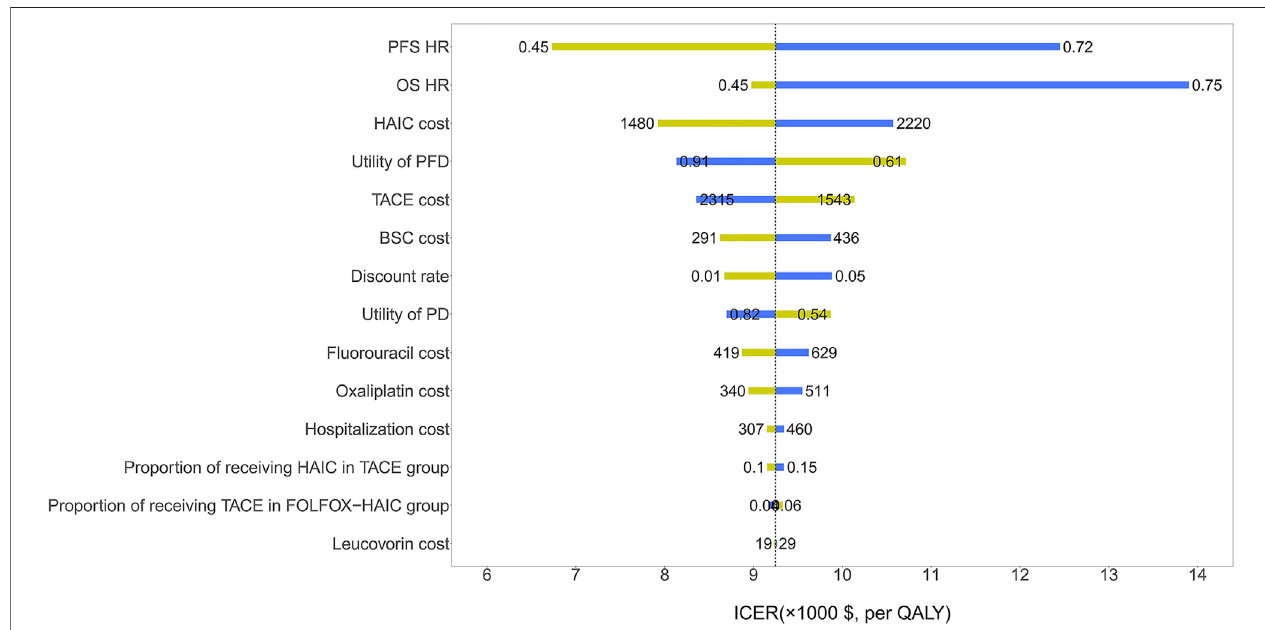
FIGURE 2 | | One-way sensitivity analysis results of the FOLFOX-HAIC strategy versus TACE strategy in all patients with large unresectable hepatocellular carcinoma. The tornado diagram shows the impact ofvarying model parameterson the incremental cost-effectiveness ratio ofthe FOLFOX-HAICstrategy compared to the TACE strategy. The dotted line intersecting the blue and yellow bar represents the ICER of $30,552/QALY from the base case results. OS, overall survival; PFS, progression-free survival; HR, hazard ratio; TACE, transarterial chemoembolization; FOLFOX-HAIC, hepatic arterial infusion chemotherapy with infusional fl uorouracil, leucovorin, and oxaliplatin; PFD, progression-free disease; PD, progressed disease; BSC, best supportive care.